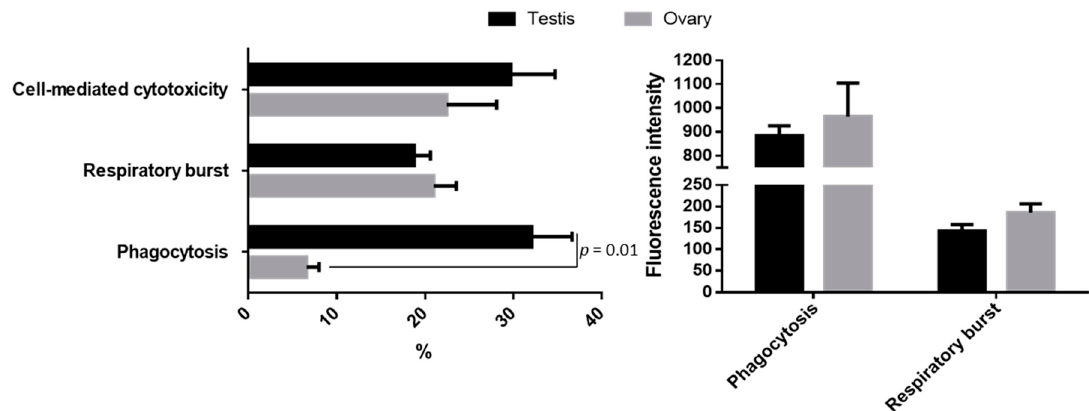
Figure 1. Cellular innate immune activities (phagocytosis, respiratory burst and cell-mediated cytotoxicity) of European sea bass testis and ovary cell suspensions determined by flow cytometry. Data represent the mean ± standard error mean (SEM) ( n = 6). Statistical analysis of the corresponding parameters between testis and ovary were determined by the t -Student test.